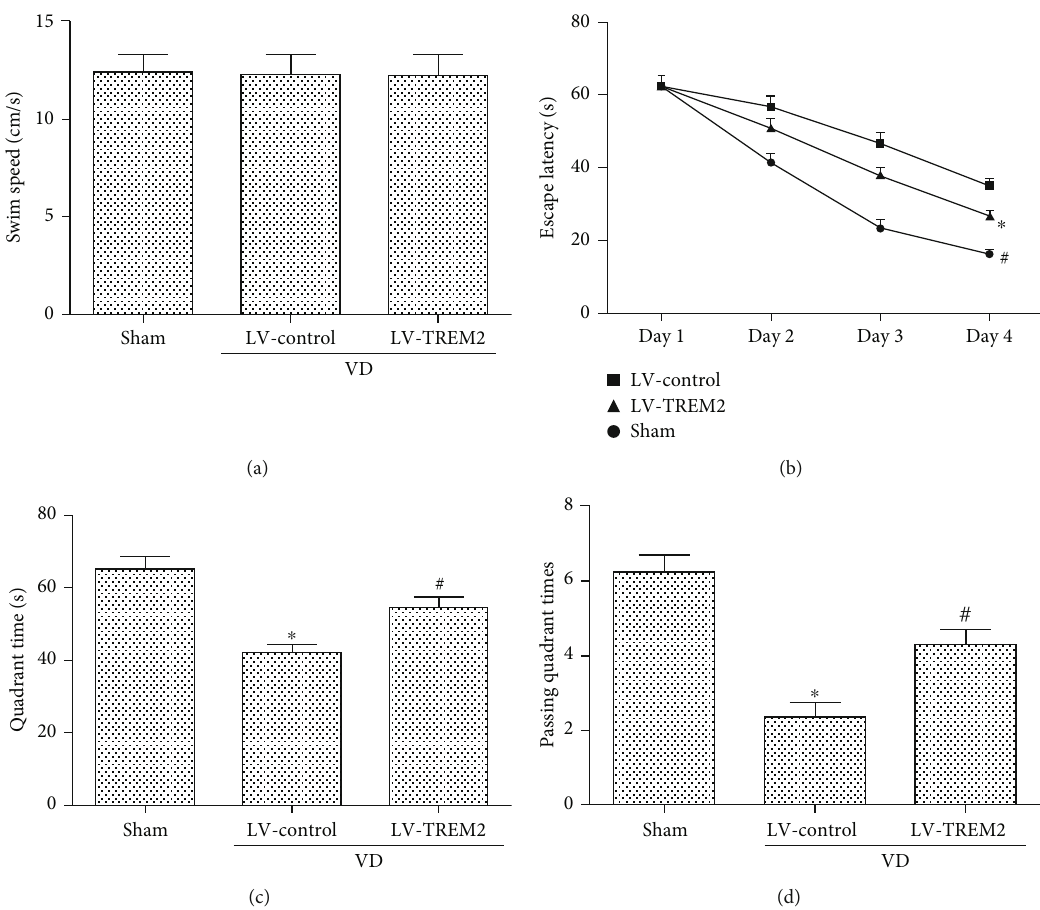
Figure 2: TREM2 overexpression attenuates cognitive de fi cits in VD mice: (a) swimming speed; (b) escape latency; (c) quadrant time; (d) passing quadrant times. Compared to the sham group, ∗ p < 0 : 05 ; compared to the LV-control group, # p < 0 : 05